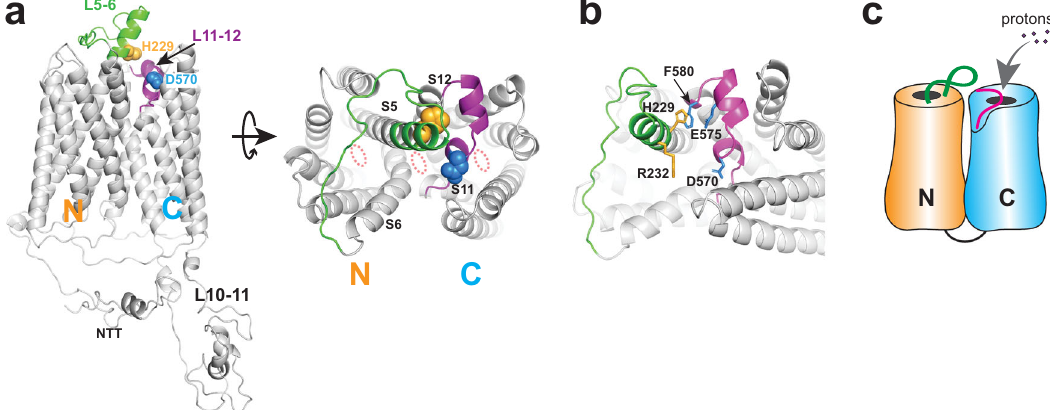
Fig. 7 A structural model of the human Otop1 channel. The structure was built with the deep learning method RoseTTAFold 32 . a The side (left) and top (right) views of the model, show the positions of the L5 – 6 (green) and L11 – S12 (purple). The fi rst 1/3 of the putative L5 – 6 was predicted to be an extension of the S5 helix. Side chains of H229 (orange) and D570 (blue) are shown as spheres. The three putative pores are indicated by dotted orange ellipses. NTT N-terminal tail. b An enlarged view to show the predicted interactions between H229 and F580, and between H229 and E575. R232 is also shown here. It is predicted to point to the pore formed at the intracellular interface. c Cartoon showing the possible initiation of proton permeation at the extracellular side of the C